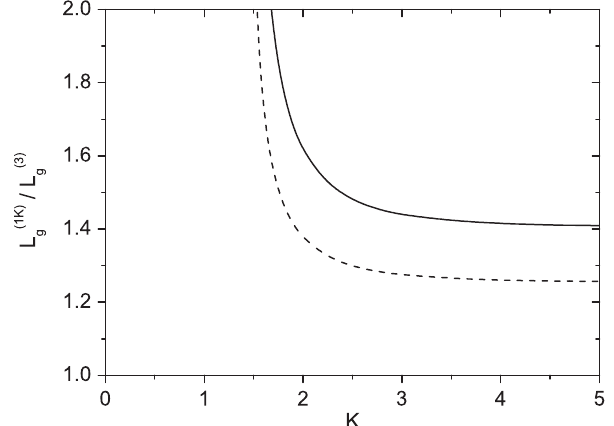
FIG. 11. Ratio of gain lengths for lasing at the fundamental wavelength and at the third harmonic. The solid curve is calcu- lated with the help of Eq. (E3) in the frame of the 3D model. The dashed curve is calculated with the help of Eq. (E1) in the frame of the 1D model. Adjustment of the fundamental wavelength was done by retuning of the undulator parameter K according to